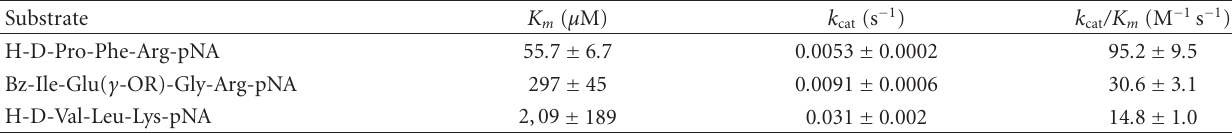
Table 2: Kinetic parameters for hydrolysis of synthetic peptides by CeSP.